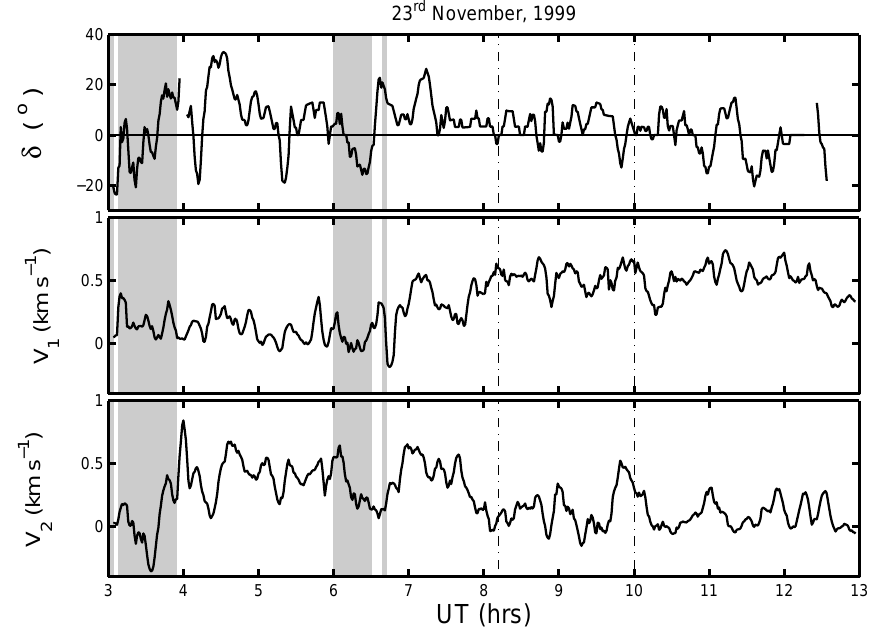
Fig. 11. (Top) Variations of the angle between the polar cap boundary and L-shells ( δ – positive values denoting a north-east to south-west orientation of the boundary). (Middle and Bottom) the line-of-sight velocities observed along beam 1 and beam 2 (V 1 and V 2 , respectively) for the range gates immediately poleward of the open-closed boundary signature. Data are 5-point running means of 1-min data. As in Fig. 3, areas shaded grey are northward IMF and the vertical dot-dashed lines mark the expansion/recovery phases of the larger substorm.